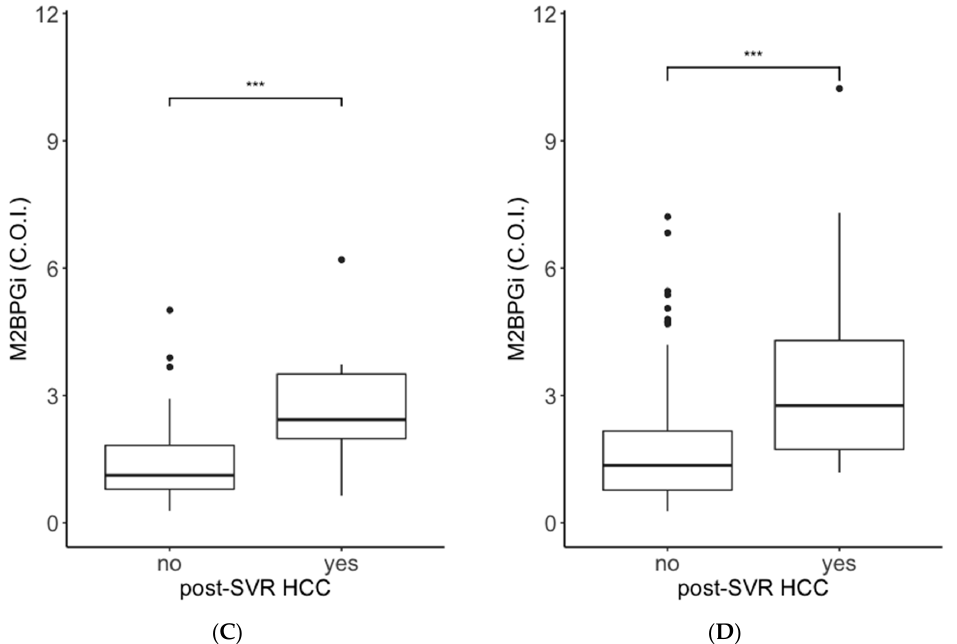
Figure 3. Comparisons of M2BPGi in patients with and without post-SVR HCC development. Data from Cohort B were used for the analysis. Data from male patients ( A , C ) and female patients ( B , D ) are shown. A and B indicate pretreatment levels, and C and D indicate those at 12 / 24 weeks after antiviral treatment. Boxes represent the interquartile range of the data. The horizontal lines in the boxes indicate the median values. The vertical lines connect the nearest values of 1.5 times the interquartile range from the quartile points. The dots indicate outliers. **: p < 0.01; ***: p < 0.001. M2BPGi: Wisteria floribunda agglutinin positive Mac-2 binding protein; SVR: sustained viral response; HCC: hepatocellular carcinoma.